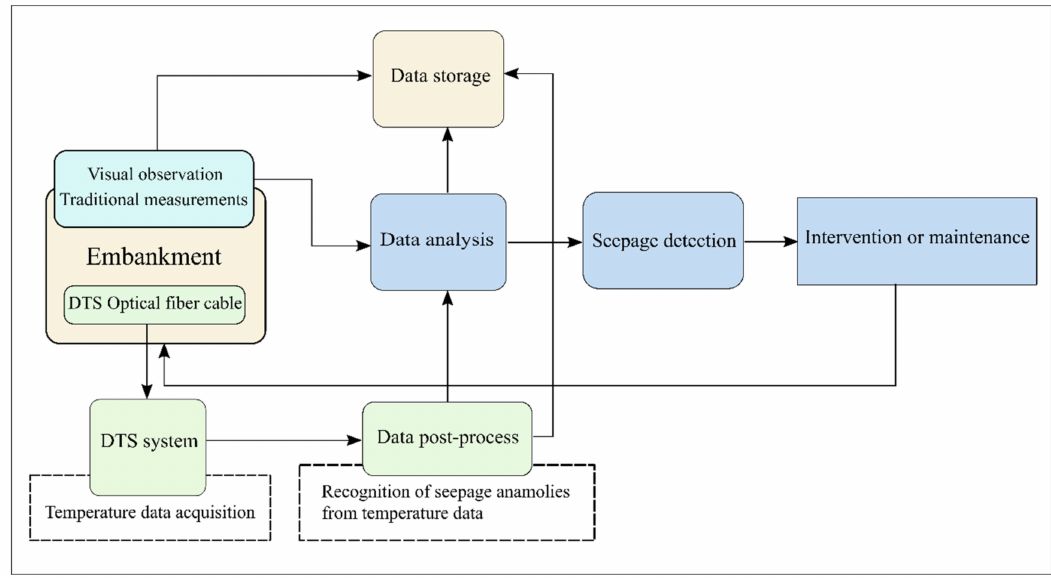
Figure 7. Monitoring and detection of seepage in the embankment